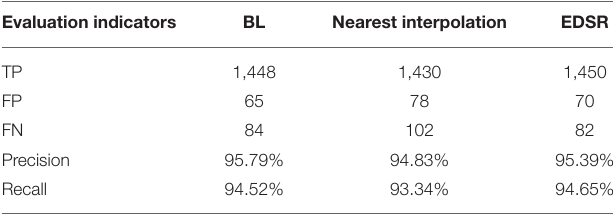
TABLE 2 | The evaluation of test_pv by using different super-resolution